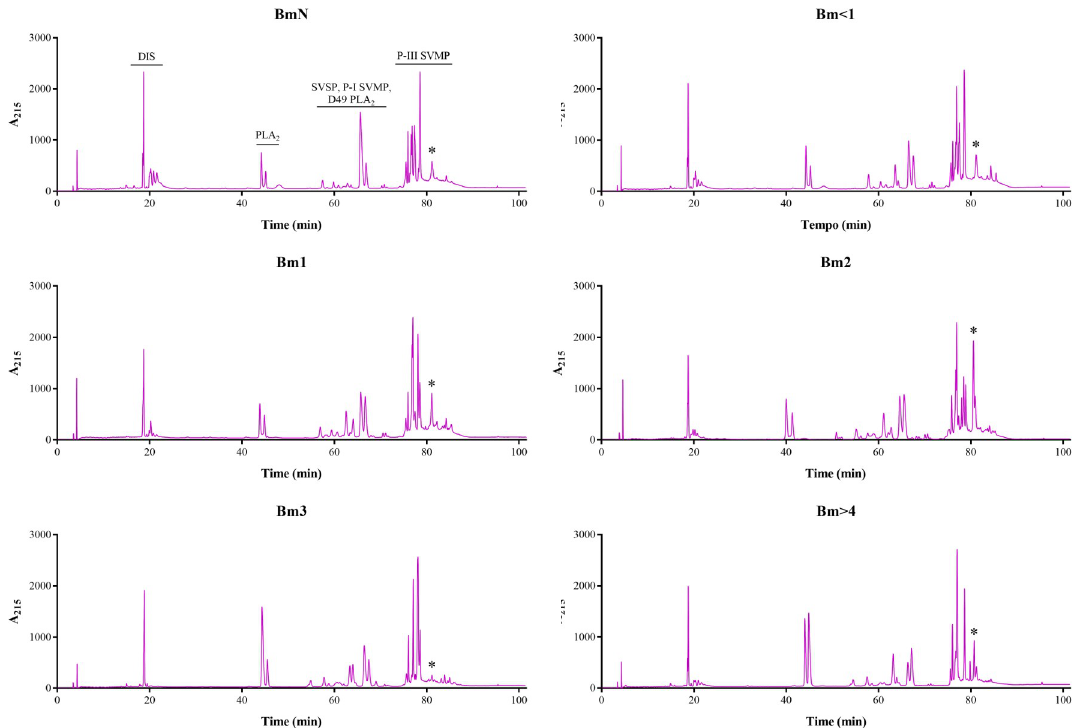
Fig 4. Venom profile of female B . moojeni at different ages by RP-HPLC. Samples of 500 μ g of lyophilized venom were dissolved in 0.1% trifluoroacetic acid (TFA; solution A) and submitted to RP-HPLC in a C18 column. Elution was carried out at 1 mL/min by applying a solution B (95% acetonitrile containing 0.1% TFA) gradient: 5% for 5 min; 5–25% for 10 min, 25–45% for 60 min, 45–70% for 10 min, 70–100% for 10 min, and 100% for 10 min. Absorbance was measured at 215 nm. � : marked peak that may be related to collagenolytic activity. DIS: disintegrin; PLA 2 : phospholipase A 2 ; SVSP: snake venom serine protease; SVMP: snake venom metalloprotease.